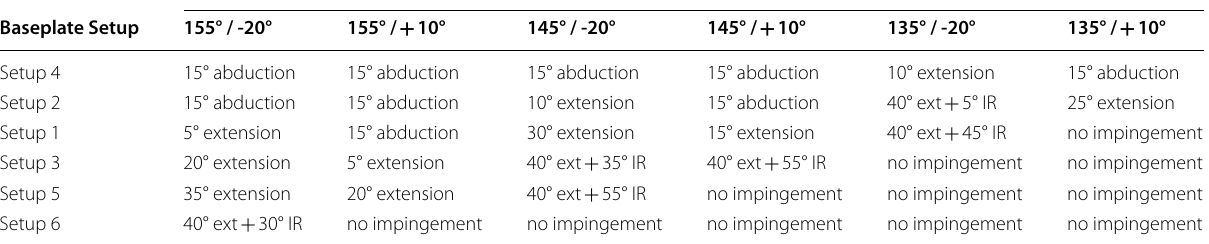
Table 2 The Impingement matrix indicates the degree of extension, or combined extension/internal rotation, at which impingement occurs. The starting position is 15° abduction. From there, the humerus was extended in 5° increments to 40°. Subsequently, internal rotation was performed in this position in 5° increments. Fields with a red background indicate that impingement already occurred in the initial position of 15° abduction. Yellow fields indicate that at least a certain degree of extension was possible before impingement occurred and blue fields indicate that a certain degree of combined extension and internal rotation in extension was possible. Green fields indicate that impingement did not occur even in full internal rotation in